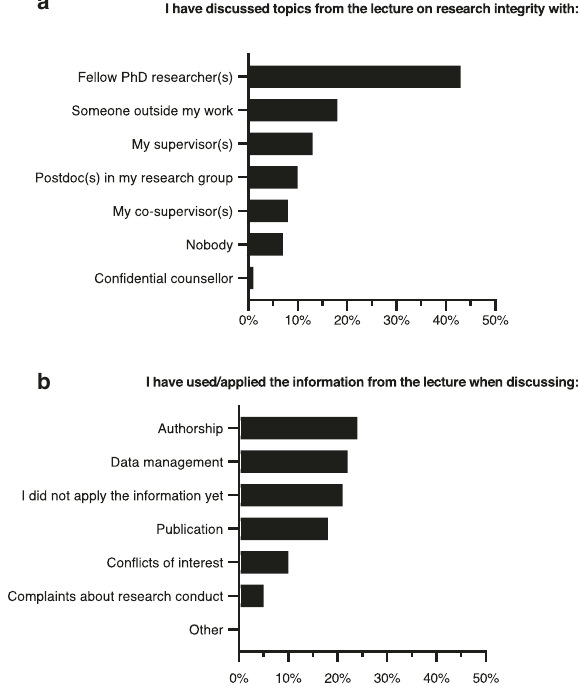
Fig. 4 Prevalence of respondents regarding having had conversations about research integrity as reported 3 months after the completion of the course. a Number and percentage of PhD students that indicated whether they had discussed topics from research integrity course with others. b Number and percentage of PhD students that indicated that they had applied/used the information received during the course. Participants were asked to check all that apply from a list of prede fi ned options, including option “ other ”